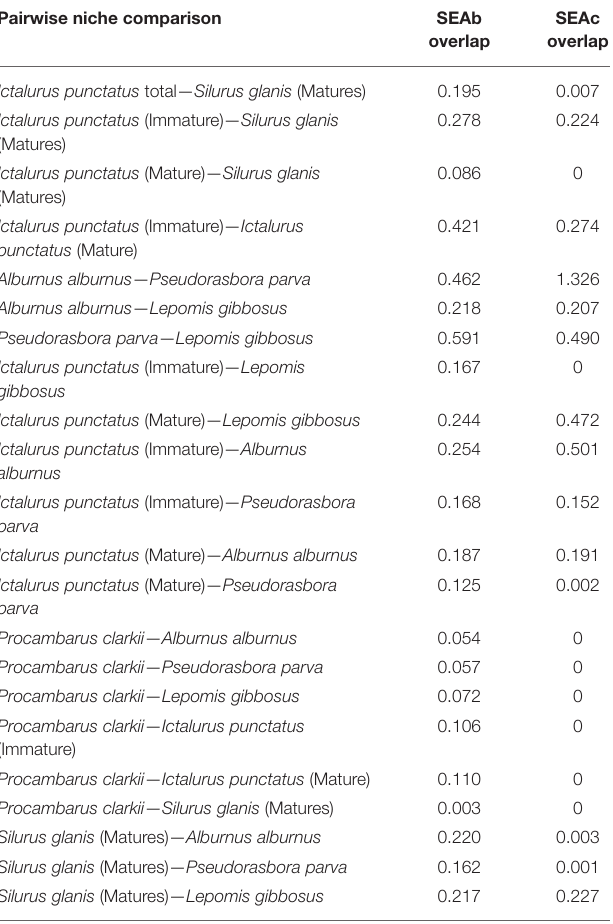
TABLE 4 | Estimated ellipses overlap between all fish species with n ≥ 5 and the crayfish Procambarus clarkii . Pairwise niche